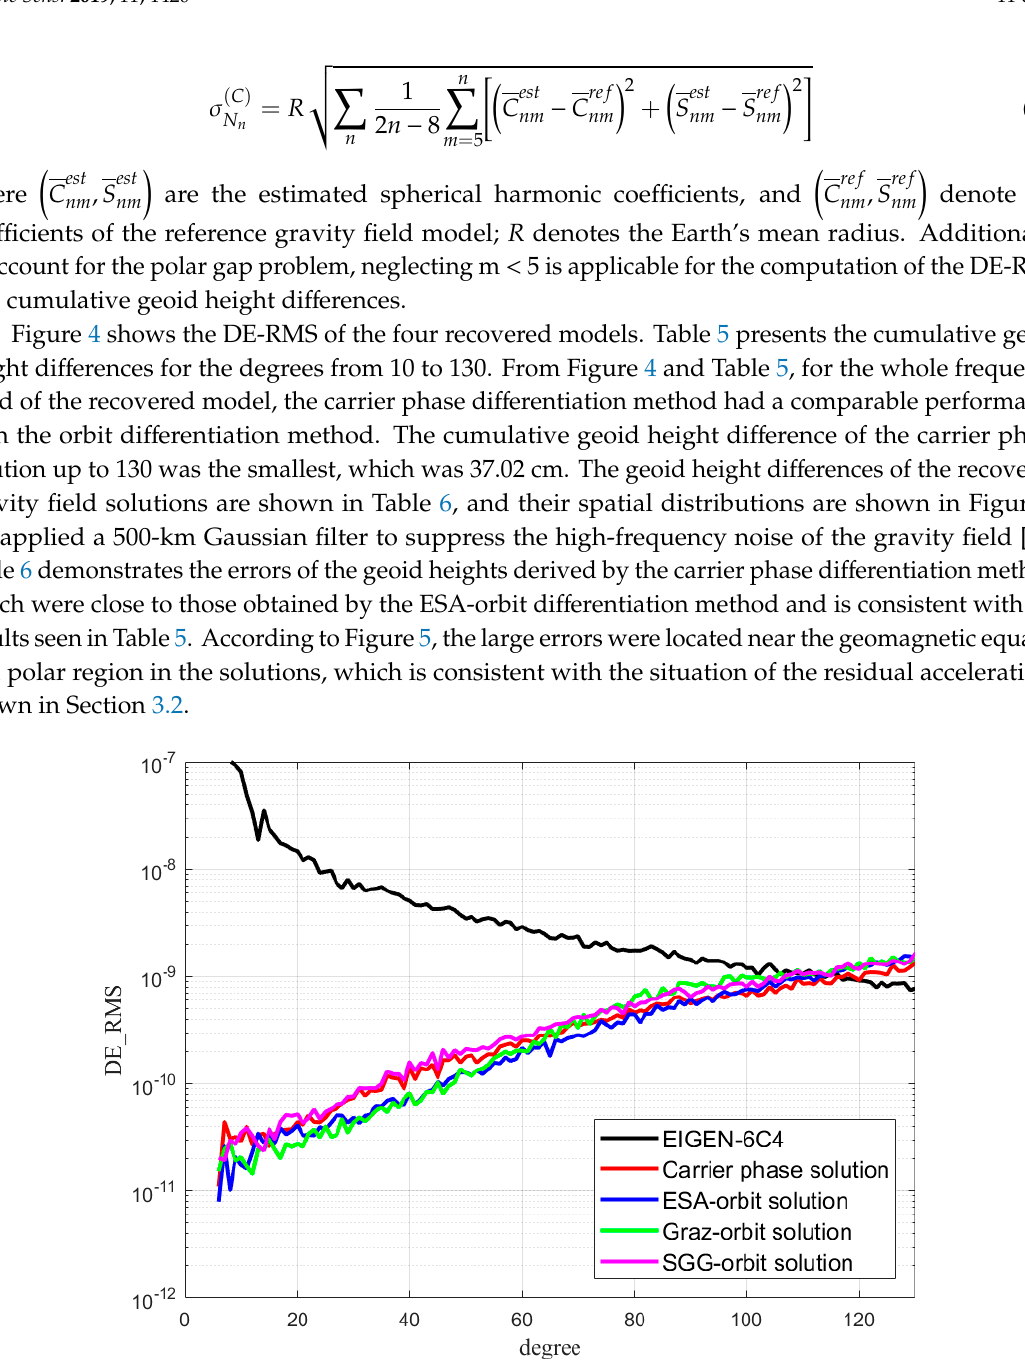
Figure 4. Degree-Error Root Mean Square(DE-RMS) of the recovered spherical harmonic coefficients w.r.t. EIGEN-6C4. Table 5. Cumulative geoid height differences (unit: cm) w.r.t. EIGEN-6C4 up to different degrees.